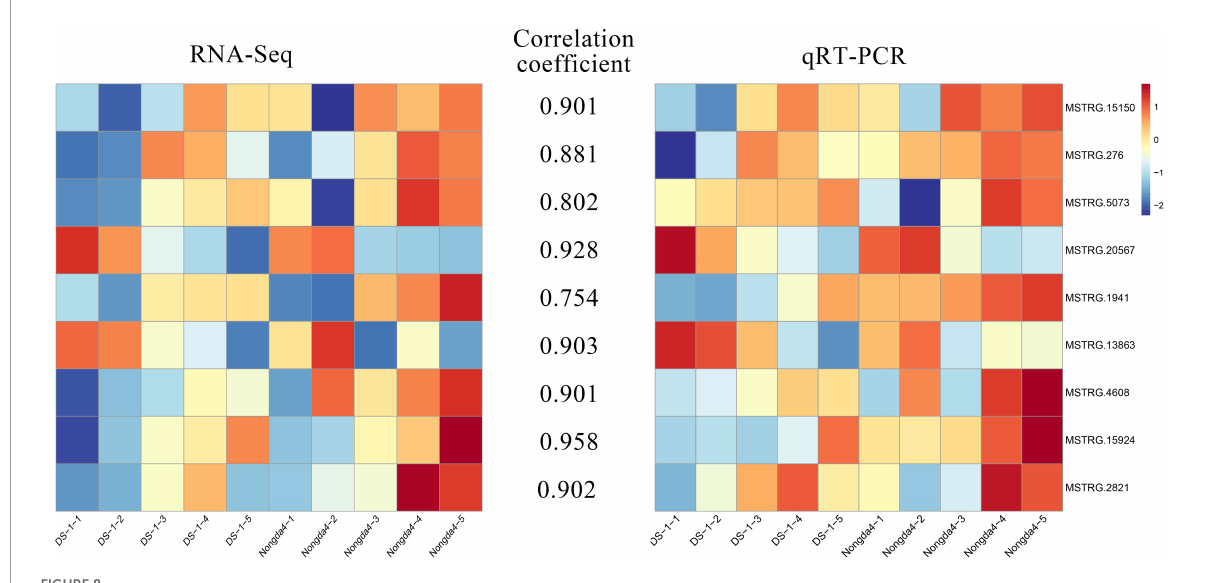
FIGURE8 qRT-PCR validation for transcriptome data. DS-1-1, DS-1-2, DS-1-3, DS-1-4, DS-1-5, Nongda4-1, Nongda4-2, Nongda4-3, Nongda4-4, and Nongda4-5 indicate DS-1 and Nongda4 fruits at S1, S2, S3, S4, and S5 developmental stages, respectively. qRT-PCR, quantitative reverse transcription-polymerase chain reaction; RNA-Seq, RNA sequencing.